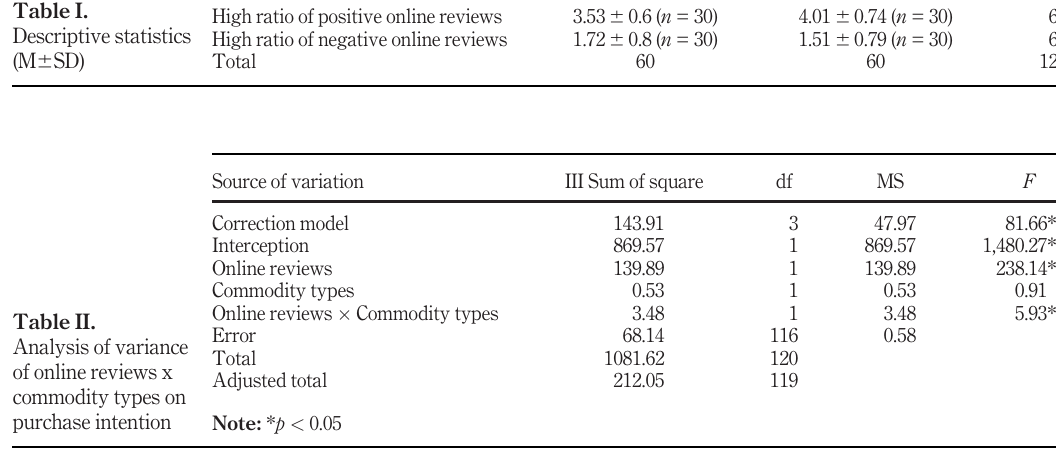
Table I. Descriptive